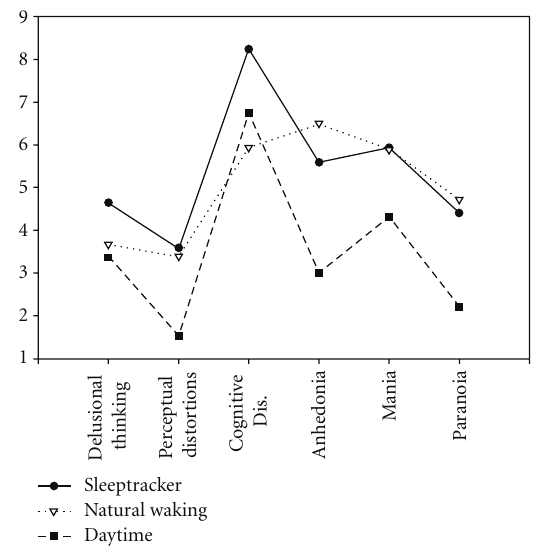
Figure 1: PSI results across the three